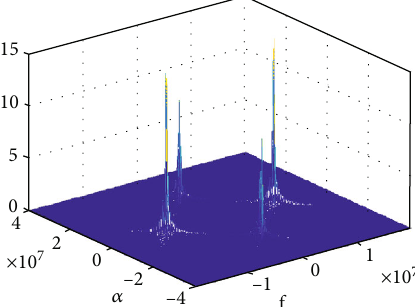
Figure 3: Cycle spectrum H